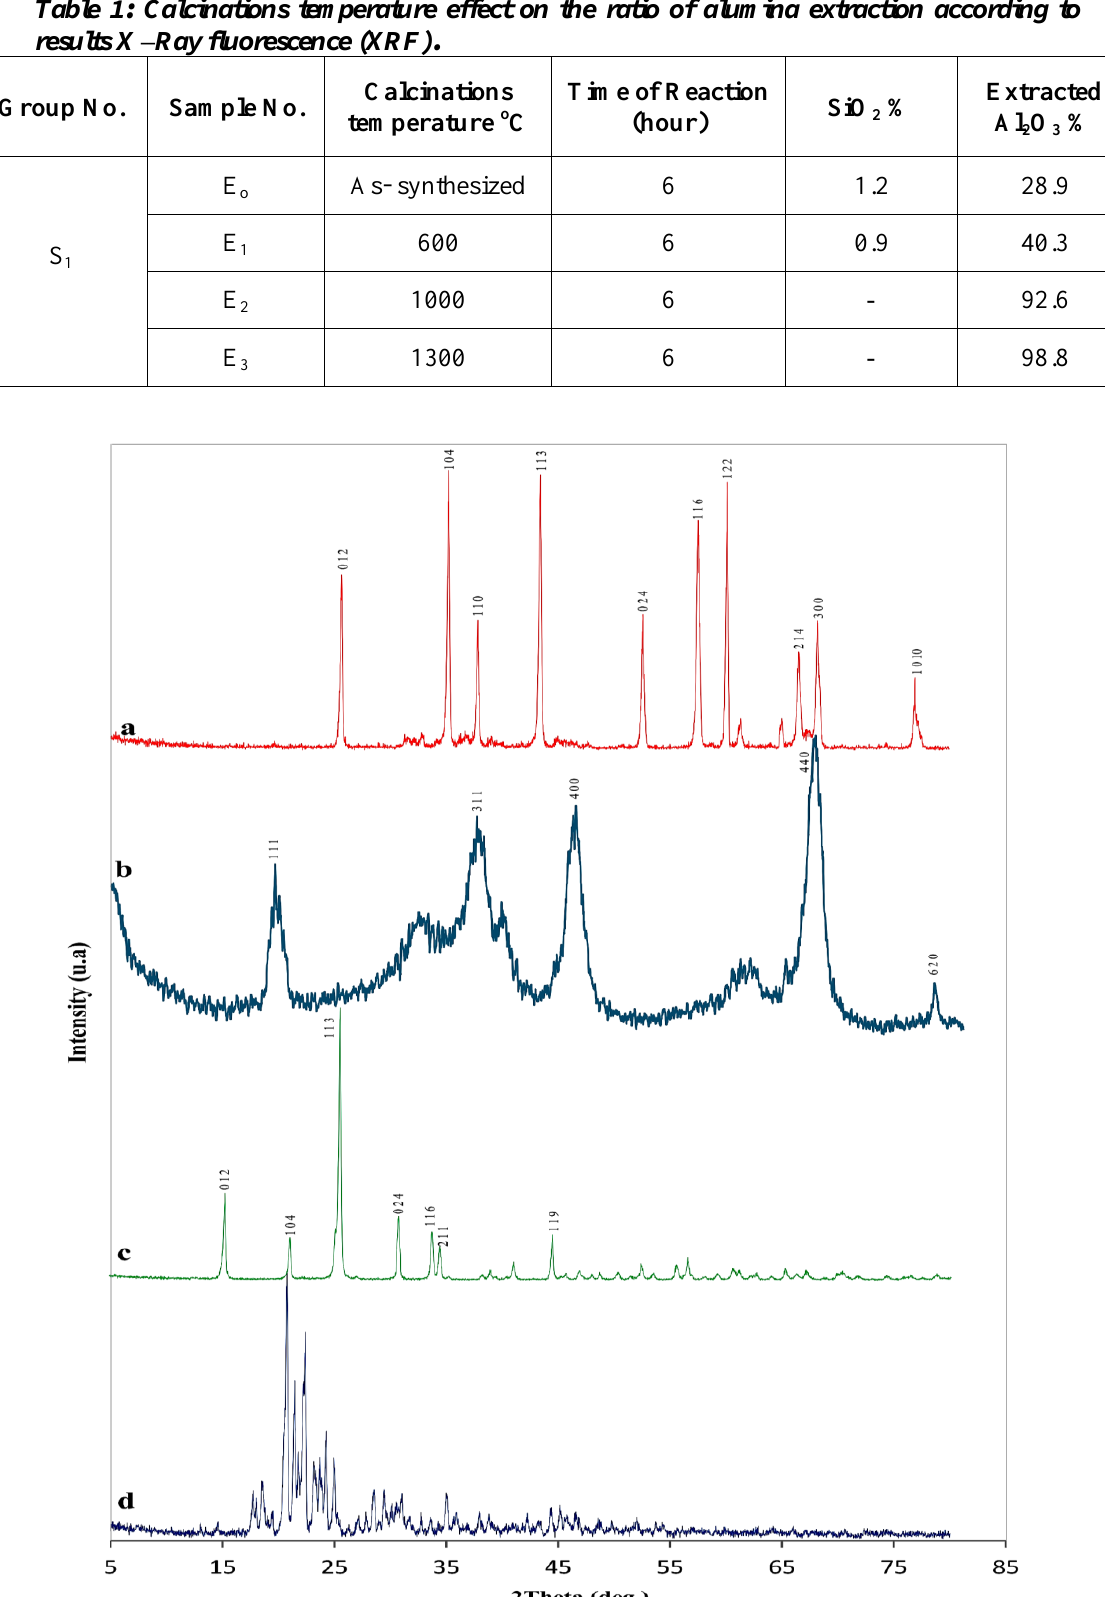
Fig. 1: XRD Pattern of group S Alumina at 1000 o C. c. Aluminum Sulfate at 600 o C. d. Hydrate Aluminum Sulfate As-